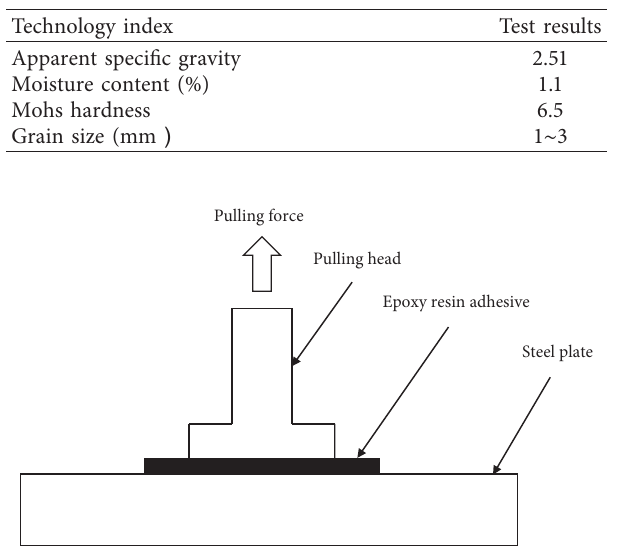
Figure 1: Drawing strength test principle.